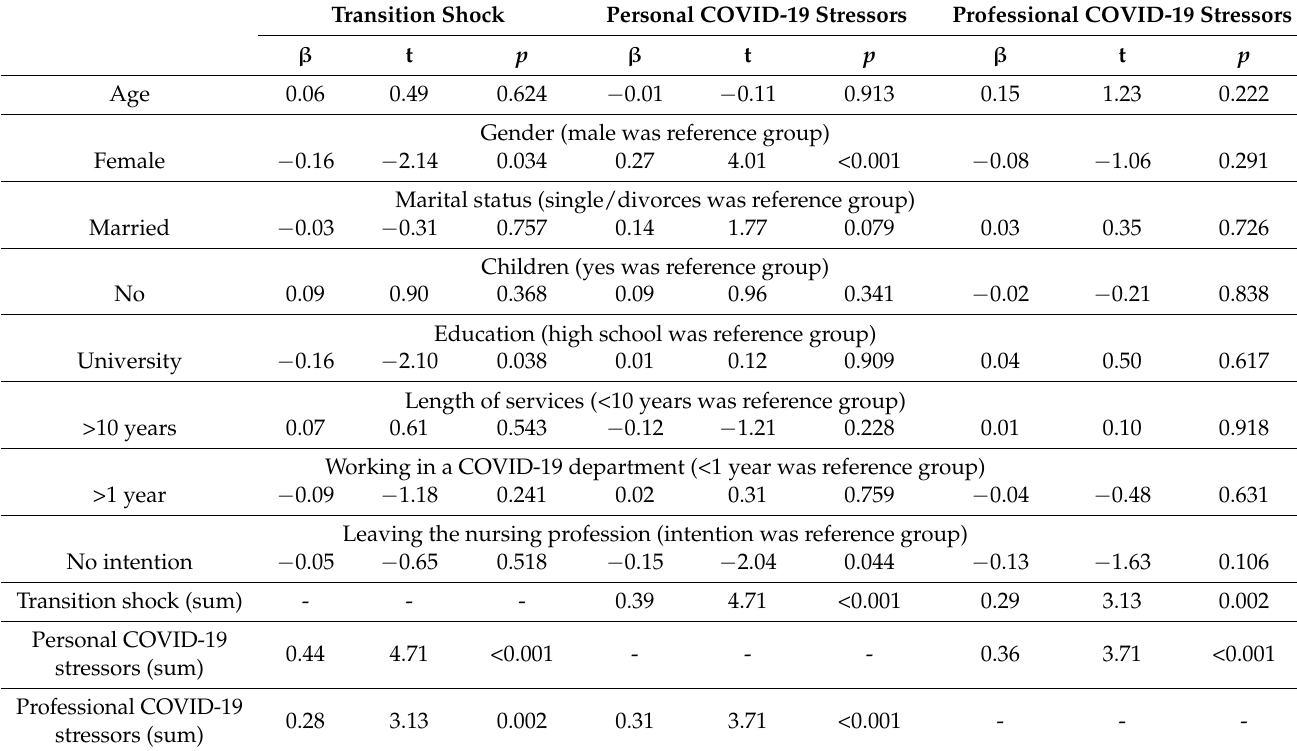
Table 3. Associations between nurses’ sociodemographic characteristics, personal and professional COVID-19 stressors, and transition shock during work in a COVID-19 department using linear regression models (N =